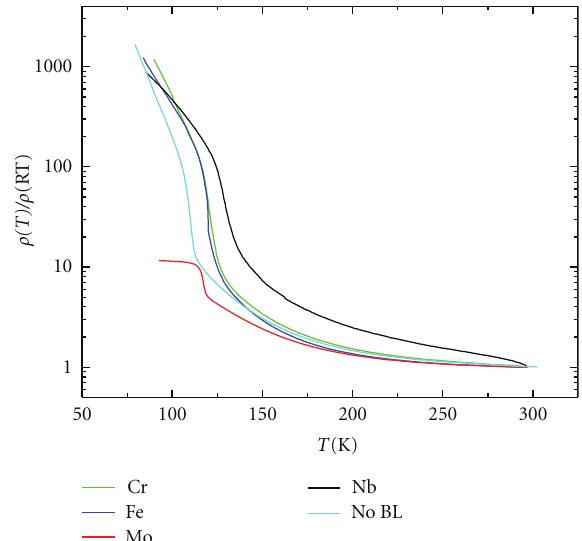
Figure 3: Change in resistivity as a function of temperature for magnetite simultaneously grown on di ff erent transition metal bu ff er layers, relative to the room temperature resistivity.